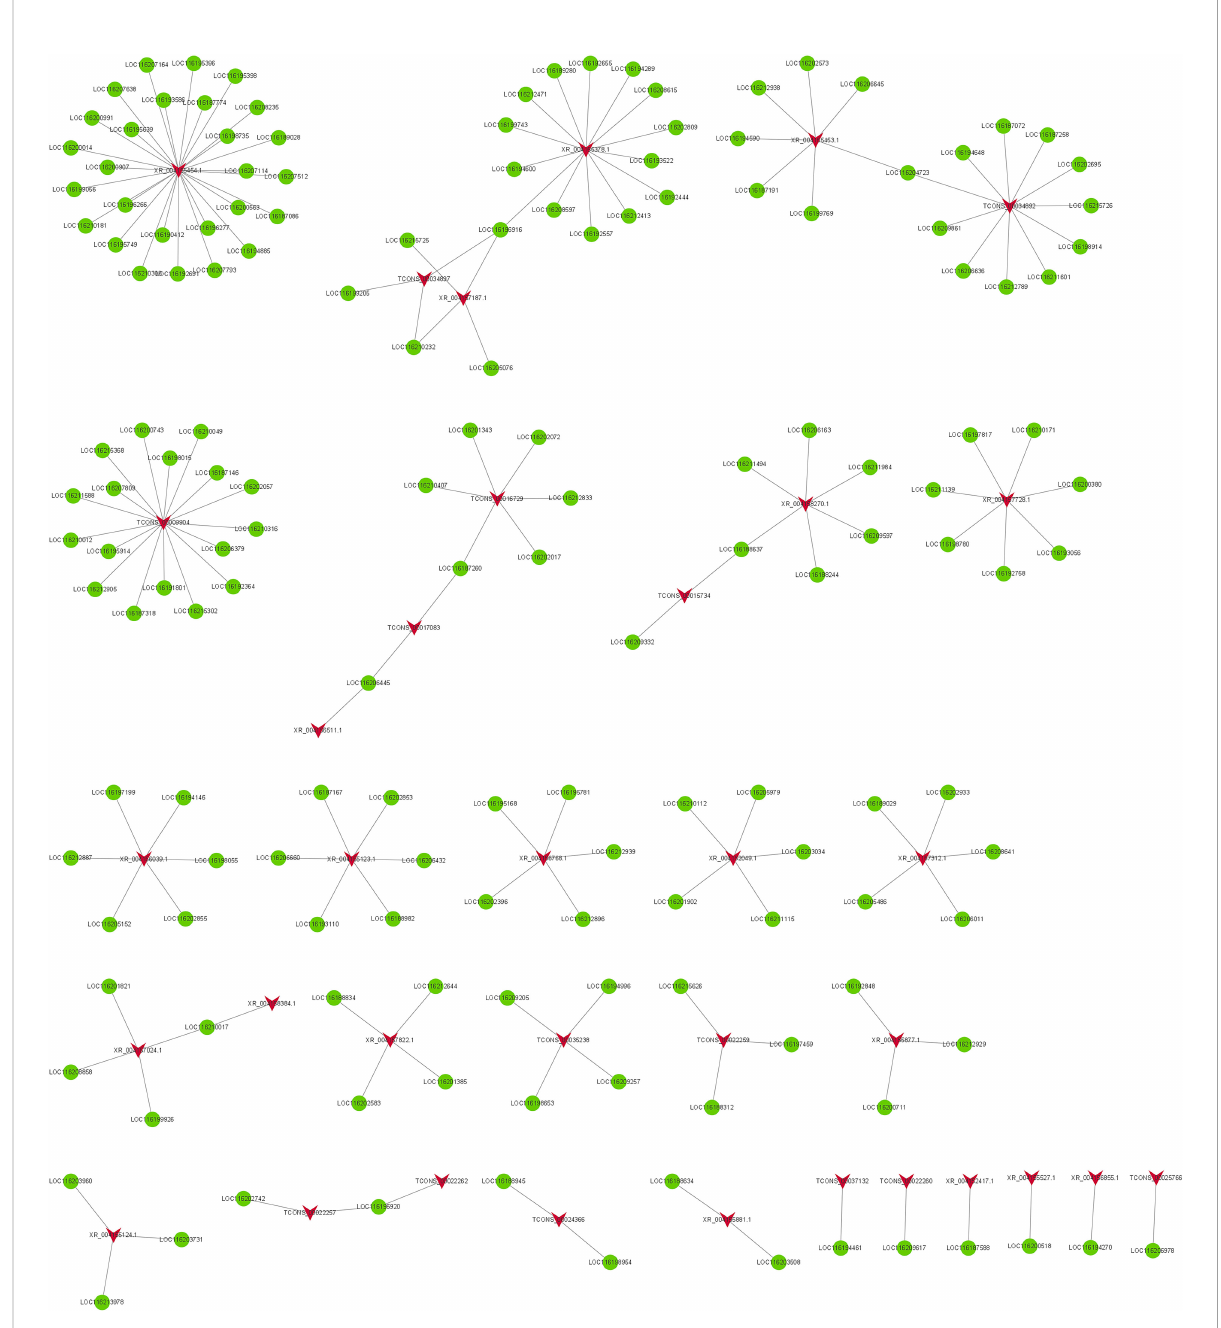
FIGURE 7 The co-expression network of differentially expressed lncRNAs (DELs) and differentially expressed mRNAs (DEGs) in FB vs FC. The red arrow node and the green circular node represent DELs and